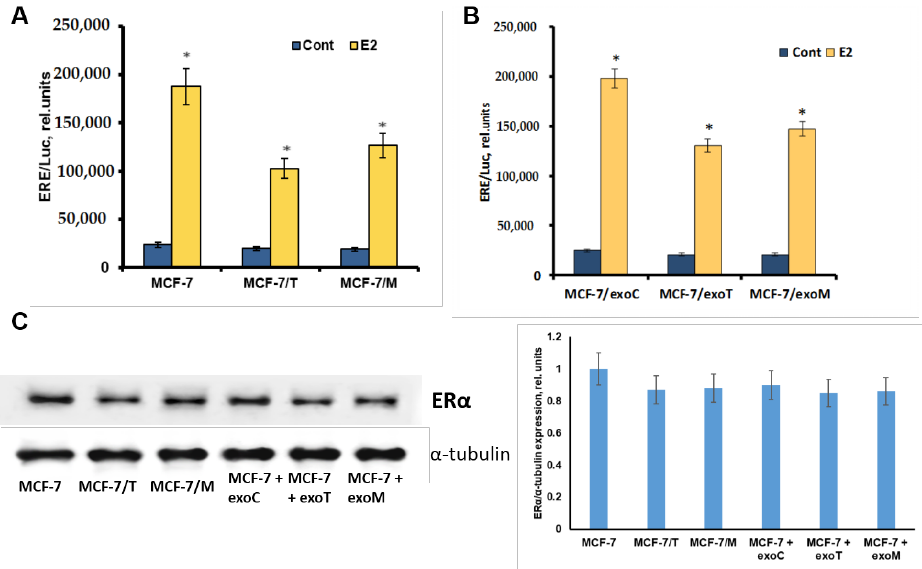
Figure 7 . Expression and transcriptional activity of ERα. All experiments were performed on the donor MCF-7, MCF-7/T, MCF-7/M cells ( A ) and MCF-7/exoC, MCF-7/exoT, MCF-7/exoM cells treated with the respective exosomes for 14 days with following exosome withdrawal for 40 days ( B ). Transcriptional activity of ERα was determined by reporter assay. The cells were transfected with the ERE-LUC plasmid containing the luciferase reporter gene under the estrogen responsive element (ERE), and β-galactosidase plasmid. 24 h after transfection the luciferase and β-galactosidase activities were determined as described in the Methods section. The relative luciferase activity was calculated in arbitrary units as the ratio of the luciferase to the galactosidase activity. Data represent mean value ± S.D. of three independent experiments. * p < 0.05 versus control (-E2) ( C ) Western blot analysis of ERα in total cell extracts. Protein loading was controlled by membrane hybridization with α-tubulin Abs. The blot represents the results of one of the three similar experiments. Densitometry was performed using ImageJ (NIH) software with the protocol provided by The University of Queensland. Densitometry data represent mean value ± S.D. of three independent experiments.